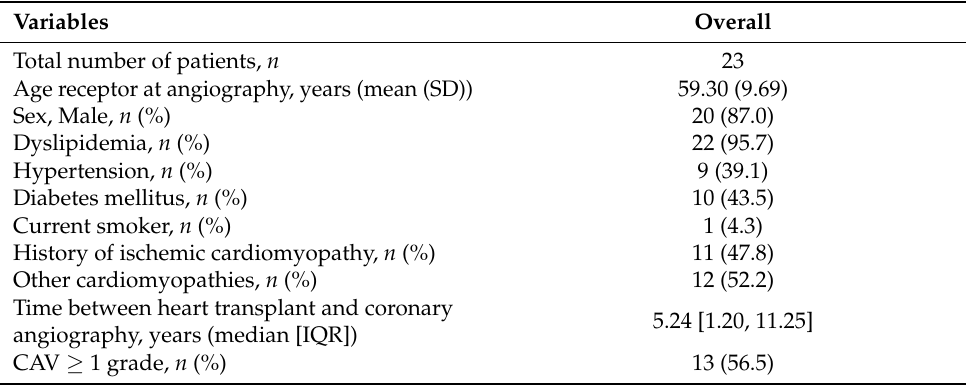
Table 1. Patient demographic and clinical